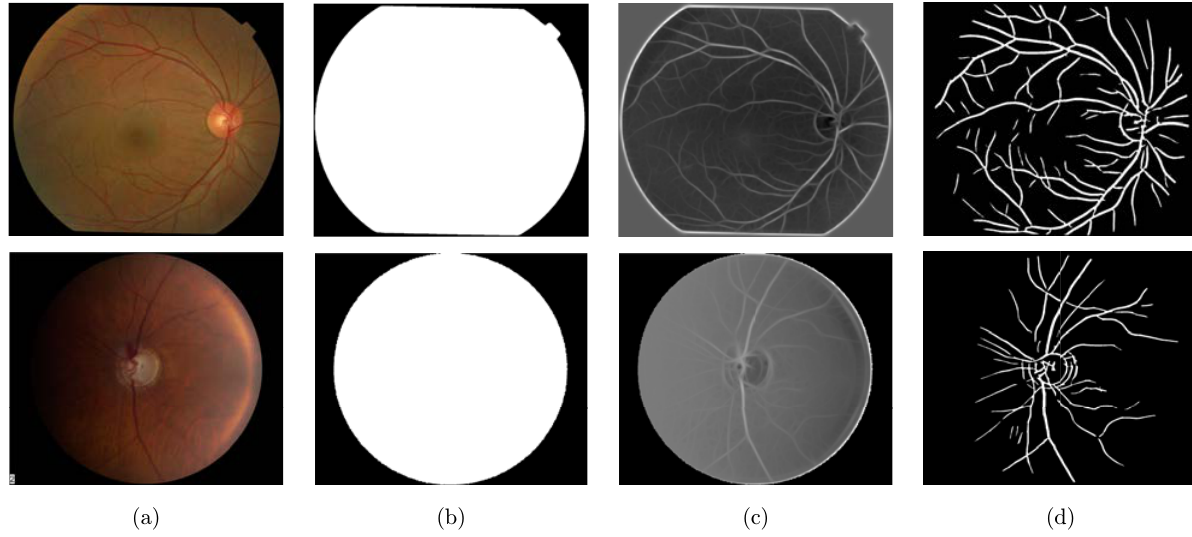
Fig. 4. Vessel preprocessing and extraction. (a) Original retinal image, (b) Background segmented mask, (c) Enhanced retinal vessels using Gabor Wavelet and (d) Binary segmented